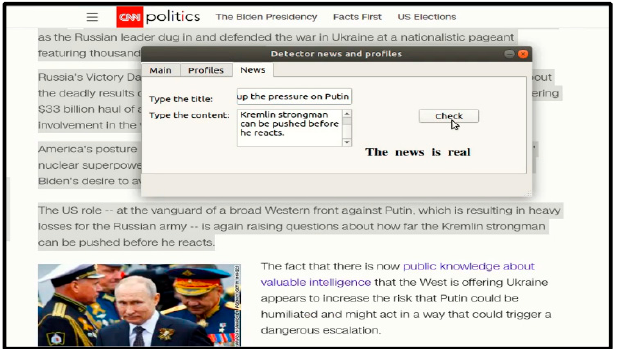
Figure 5. The result of detecting the status of news on Twitter as either fake or legitimate .